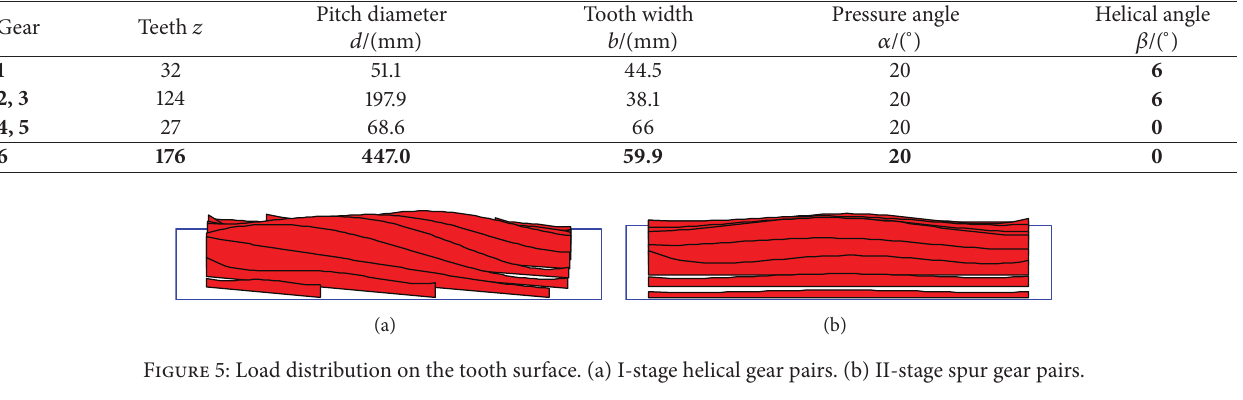
Table 1: Gear parameters.